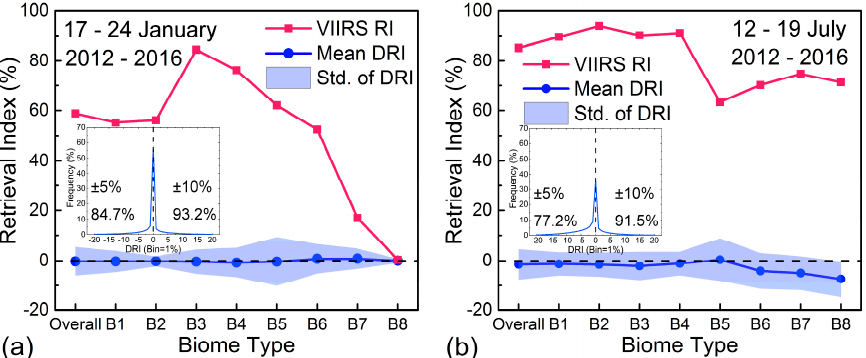
Figure 7. The retrieval index (RI) of VIIRS main algorithm (red line), the mean Difference of RI (DRI) (blue line) and the standard deviation (blue shadow) of DRI (the difference of RI was first calculated in each 10 km × 10 km grid, and then the mean and std. were calculated for all grids) between VIIRS and MODIS products (VIIRS-MODIS) for different biome types on ( a ) 17–24 January and ( b ) 12–19 July from 2012 to 2016. The inset figure in each panel shows the histogram of DRI between VIIRS and MODIS products.